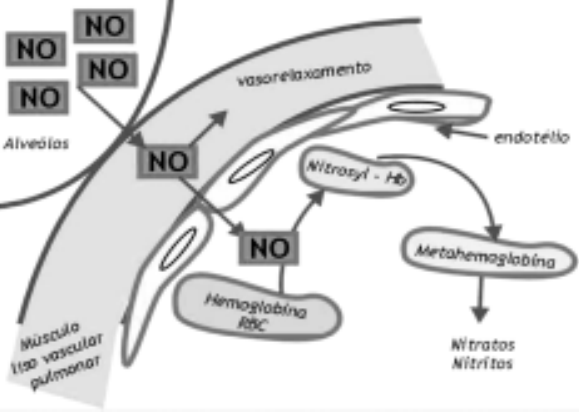
Fig. 1 - Desenho esquemático da ação do NO no alvéolo pulmonar (Baseado em Fullerton et